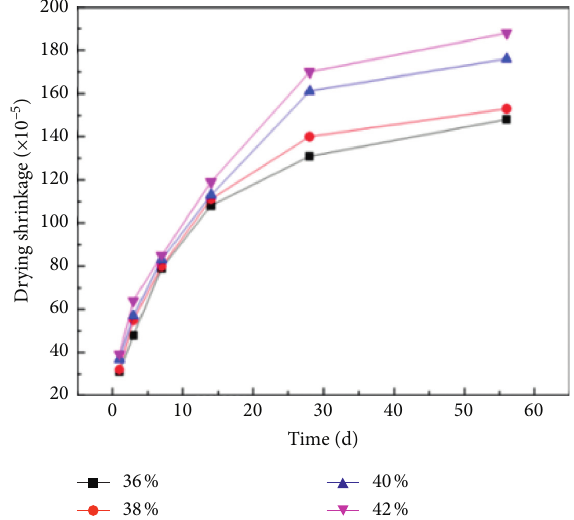
Figure 8: Influence of the activator concentration on the drying shrinkage rate of geopolymers.